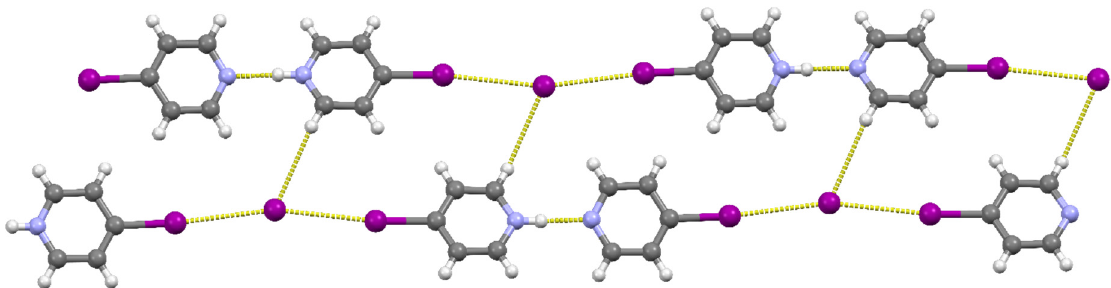
Figure 5. [( 4-IPy ) 2 H] + hydrogen bonded complexes and iodide anions connected through C − I ⋯ I − halogen bonds and C − H ⋯ I − hydrogen bonds into double chains in the structure of [( 4-IPy ) 2 H]I.